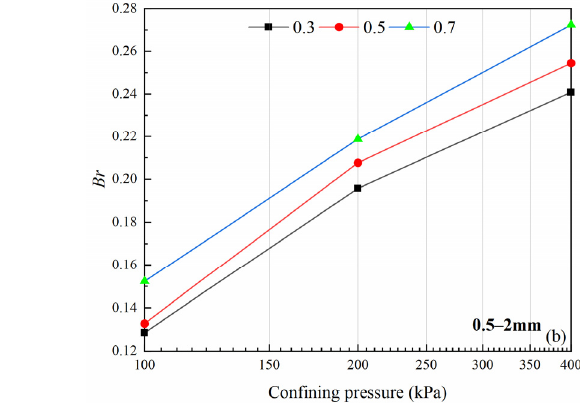
Figure 15. Variations in relative breakage rate ( Br ) with different relative density ( Dr ) and confining pressure( σ 3 ): ( a ) 2–5 mm particle groups; ( b ) 0.5–2 mm particle groups.